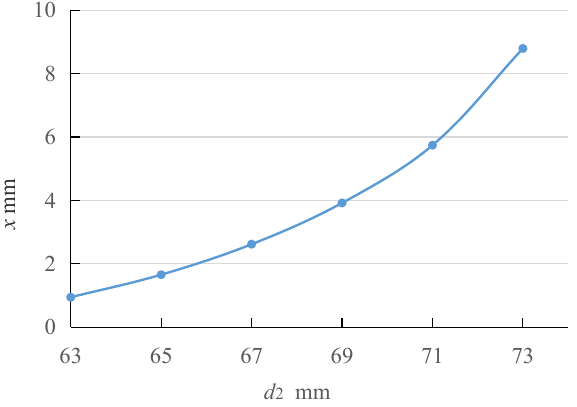
Figure 7. Relationship between d 2 and x.